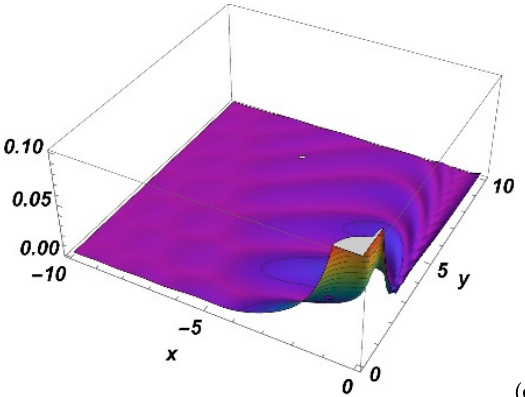
(cid:12) (cid:12) (cid:12) P A ( x , y ) (cid:12) ( b ) and the absolute value of the functions’ di ff erence A